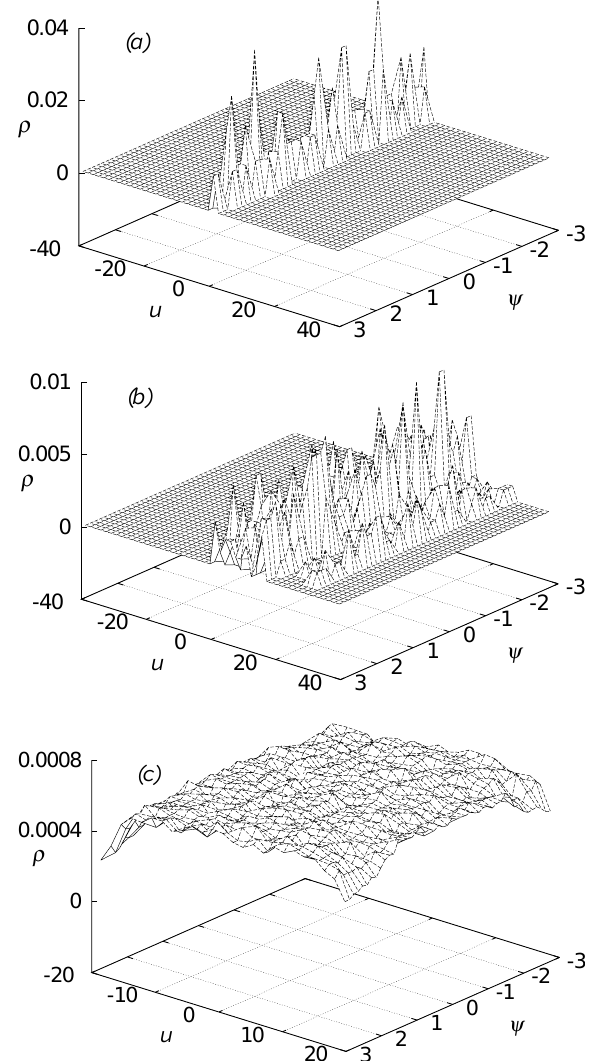
Fig. 6. Joint distribution ρ(ψ,u) computed numerically via g n at several different numbers of steps: (a) 10 2 , (b) 10 3 , and (c) 2 × 10 6 . The parameters are the same as in Fig.